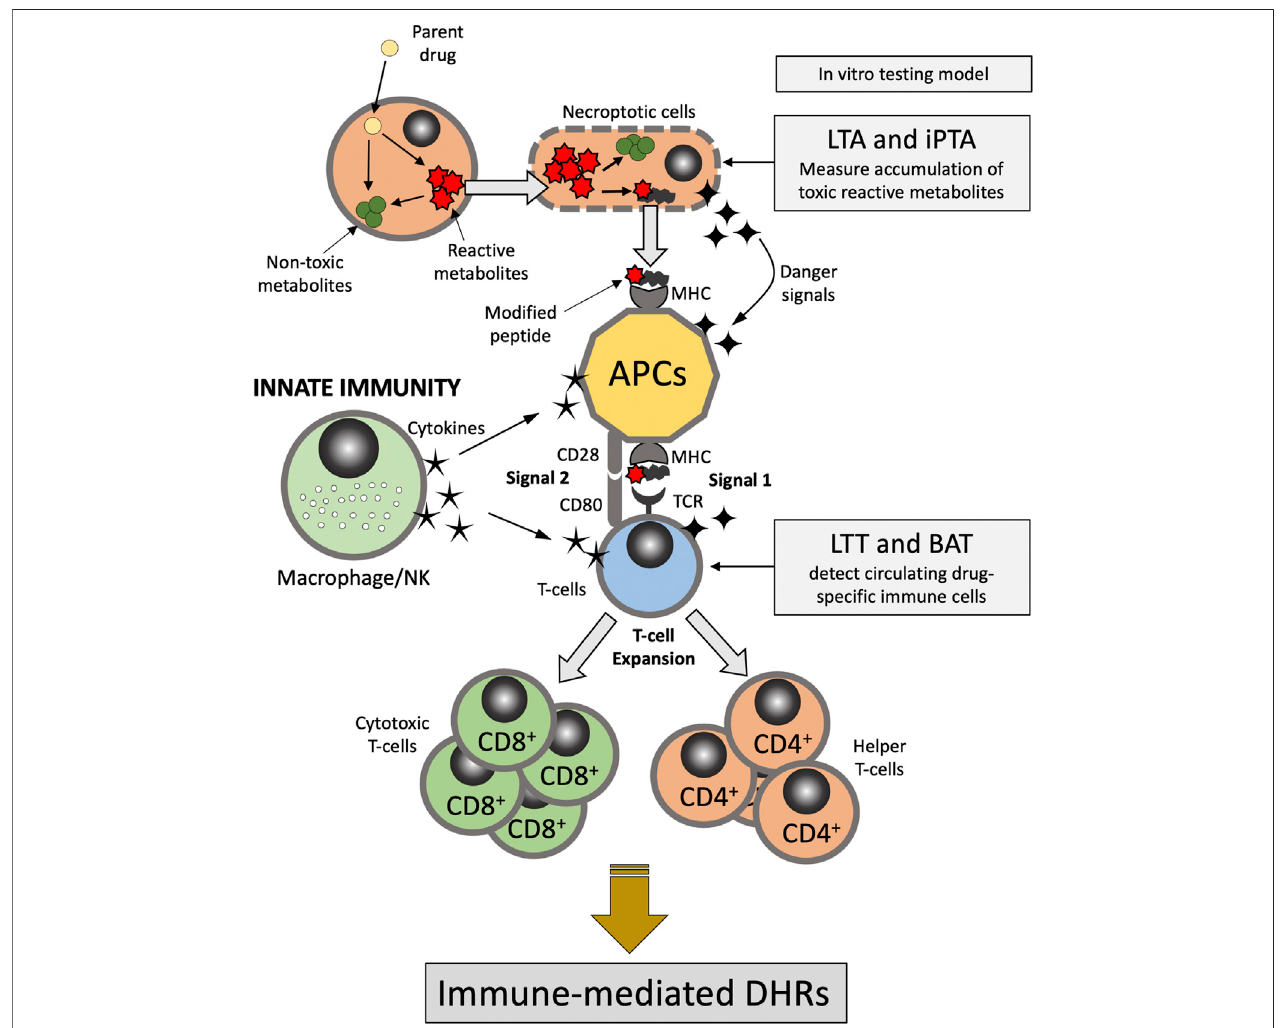
FIGURE 1 | Pathophysiology of delayed-type DHRs. APC, antigen presenting cells; BAT, basophil activation test; DHRs, drug hypercreativity reactions; iPTA, invitro platelettoxicityassay;LTA,lymphocytetoxicityassay;LTT,lymphocytetransformationtest;MHC,Majorhistocompatibilitycomplex;NK,naturalkiller;TCR,T-cell